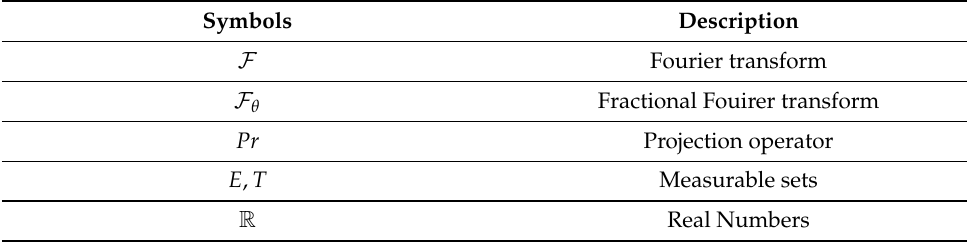
Table 1. Symbol Description. Symbols Description F Fourier transform F θ Fractional Fouirer